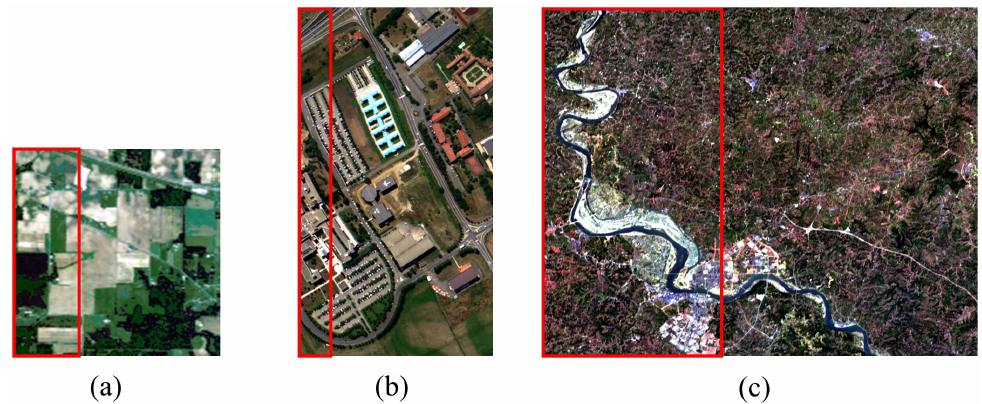
Figure 3. Color-combination images of three MSI–HSI datasets employed in the experiment. ( a ) In- dian Pines data. ( b ) Pavia University data. ( c ) ZY1-02D data. The MSI–HSI image pair of the highlighted areas in the red rectangle is used for training, and the MSI of the remaining areas is used for